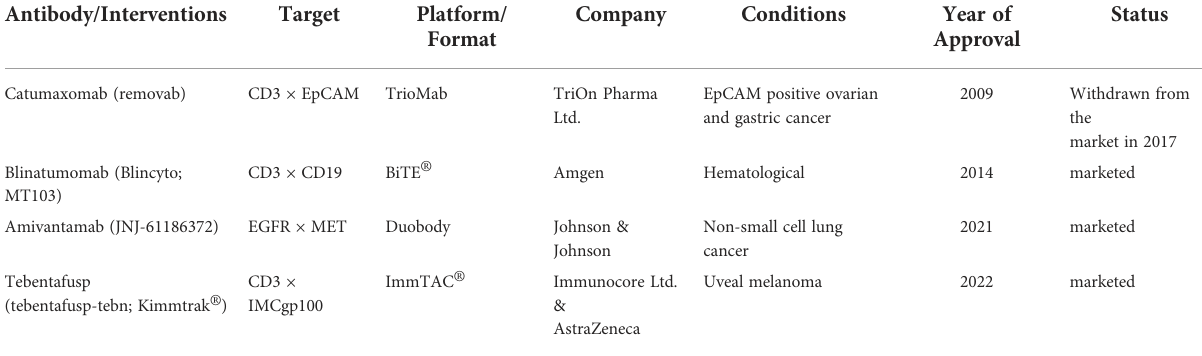
TABLE 1 Bispeci fi c Antibody Approved by the FDA.